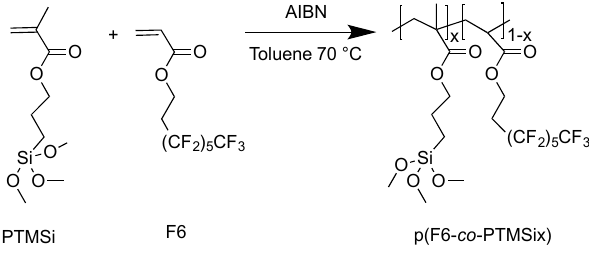
Figure 3. Synthesis of the fluorinated copolymers based on hydrophobic F6 and PTMSi (x = 1, 5 mol%).